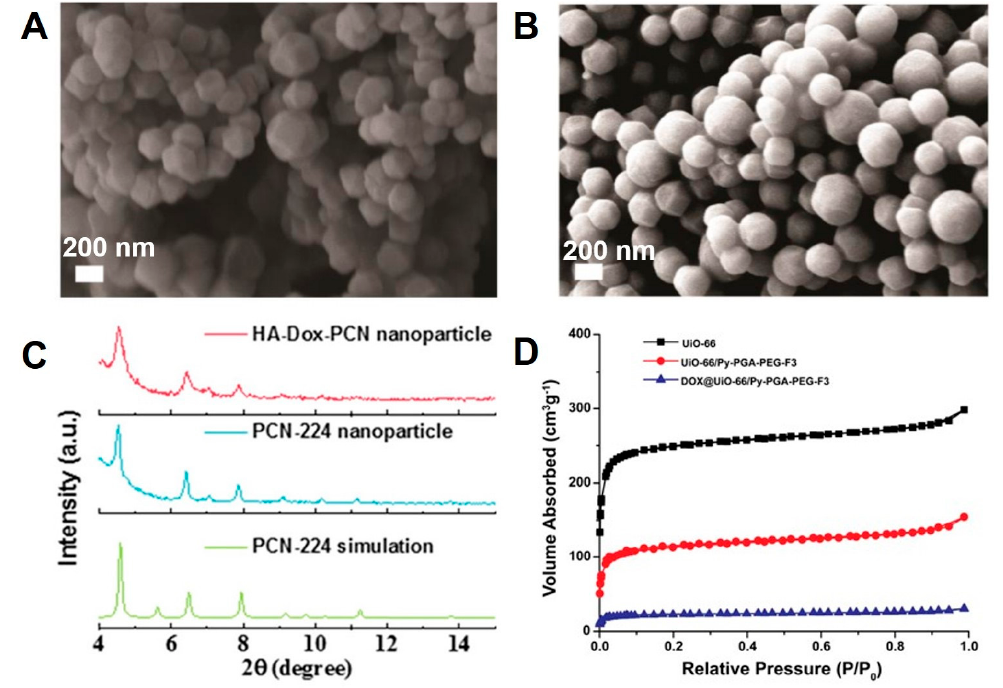
Figure 14. SEM images of ( A ) UiO-66-L2 and ( B ) UiO-66-L2-PNIPAM. Reproduced with permission from Ref. [142] Copyright 2018, American Chemical Society. ( C ) PXRD pattern of PCN-224, HA-Dox-PCN-224. Reproduced with permission from Ref. [126] Copyright 2019, American Chemical Society. ( D ) Nitrogen adsorption-desorption isotherms of UiO-66, UiO-66/Py-PGA-PEG-F3, and DOX-loaded UiO-66/Py-PGA-PEG-F3. Reproduced with permission from Ref. [140] Copyright 2017, American Chemical Society.